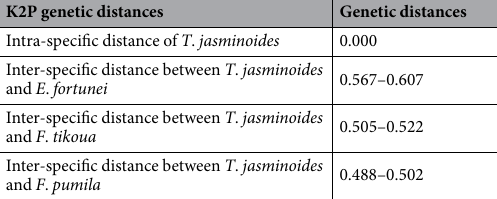
Table 2. Analysis of intra-specific variation and inter-specific divergence of the ITS2